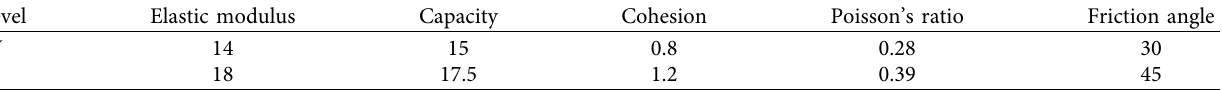
Table 5: Physical and mechanical performance parameters of surrounding rock materials in model tests.